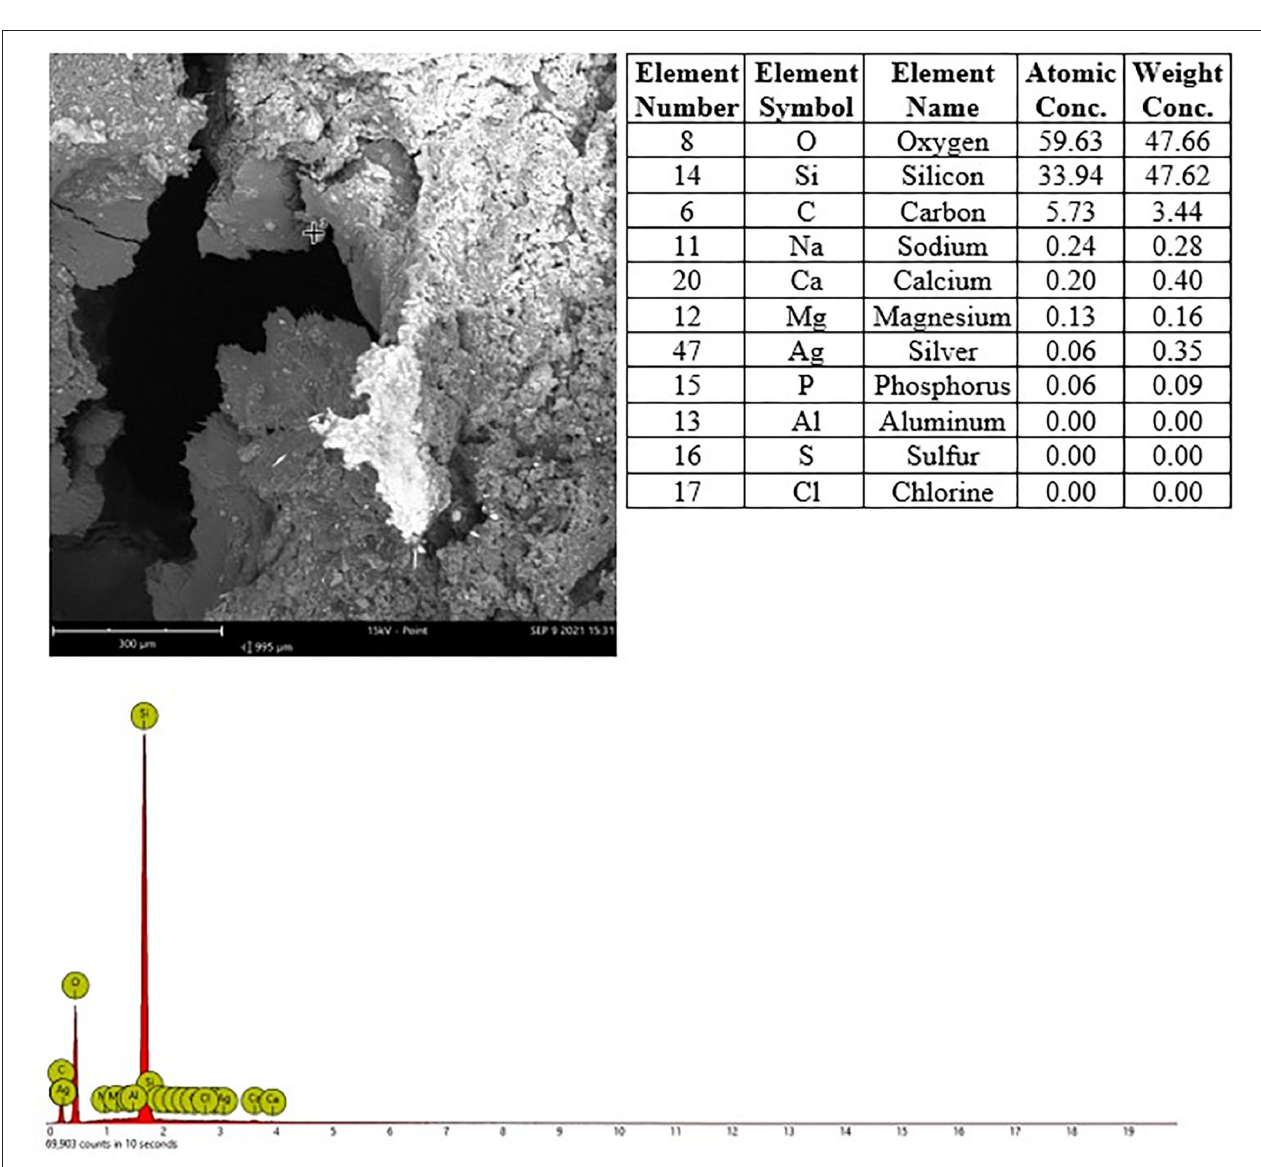
FIGURE 6 | Male rat. Deceased after 3 ¼ h after start of inhalation, Nasal cavity, frozen and dried, level 4, area 2, EDX point analysis showing SEM image, EDX spectrum, and atomic and weight concentration table of detected Si.